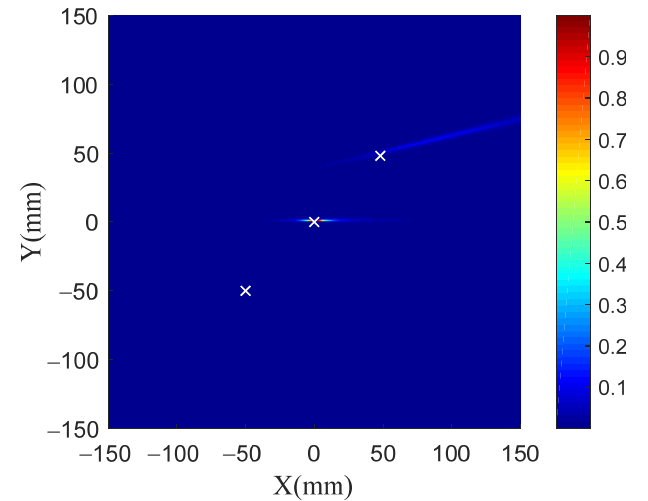
Table 2. Comparison of identified and real damage locations of three damage cases. Damage No.